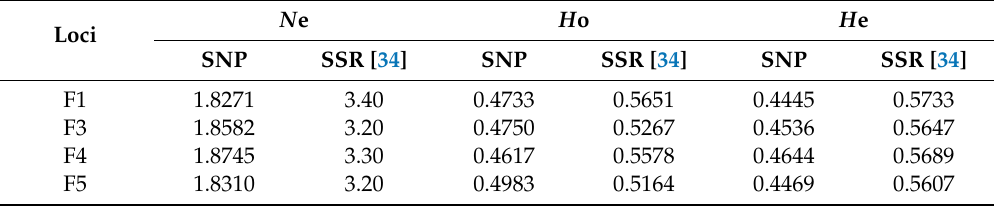
Table 5. Comparison of genetic indexes determined using SNP and SSR markers.